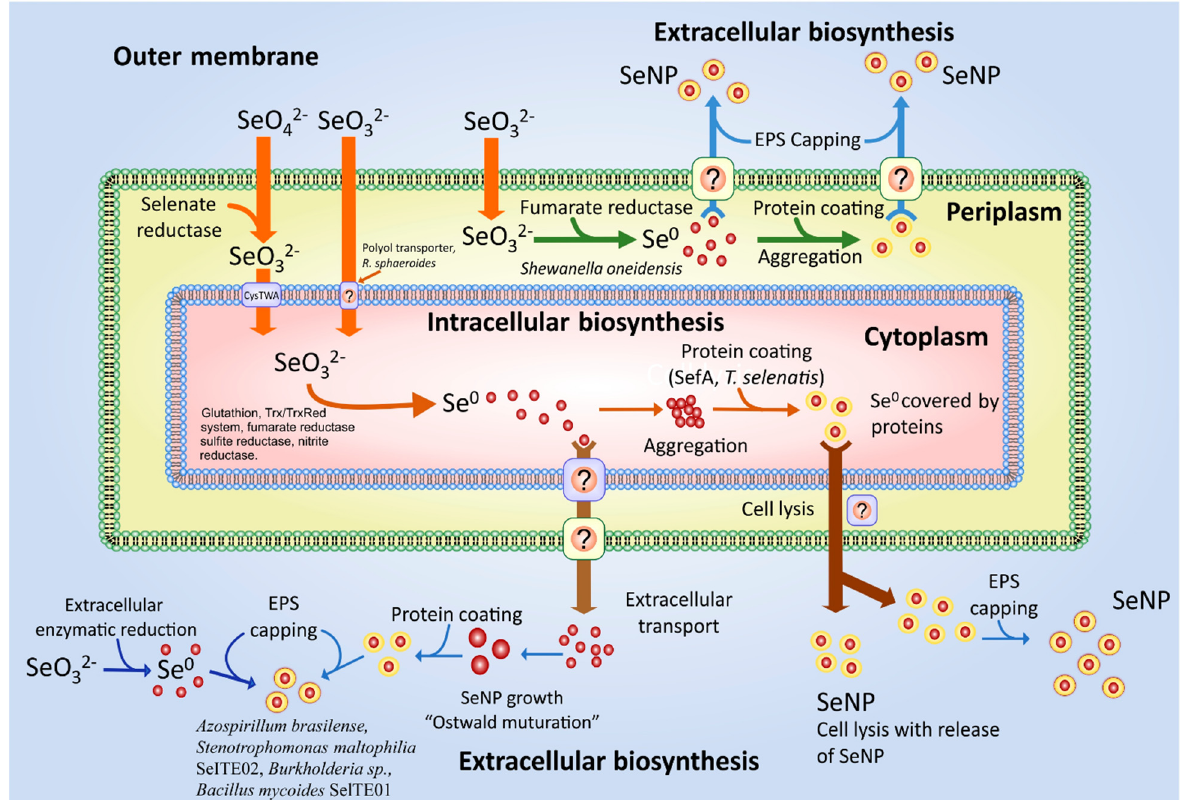
Figure 3. Mechanism of selenite reduction to selenium nanoparticle. Image based on Jain et al. [126] and Sinharoy et al. [127].